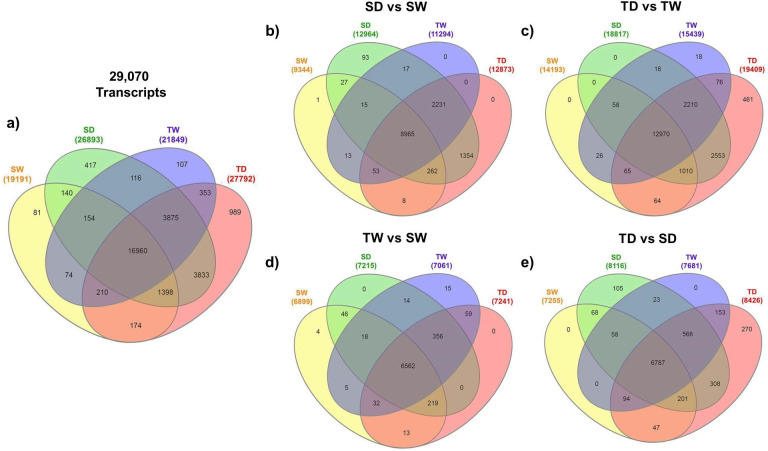
Venn diagram for differentially expressed genes in both papaya genotypes under well-watered or WDS conditions.Genes of reference transcriptome expressed in both genotypes under well-watered (SW and TW) or after they were subjected to WDS for 14 d.p.t. (SD and TD) (a). DEGs obtained for: SD vs SW (b), TD vs TW (c), TW vs SW (d) and TD vs SD (e). Numbers in each intersection represent the number of detected genes with at least one read (gene tag) in these intersections.